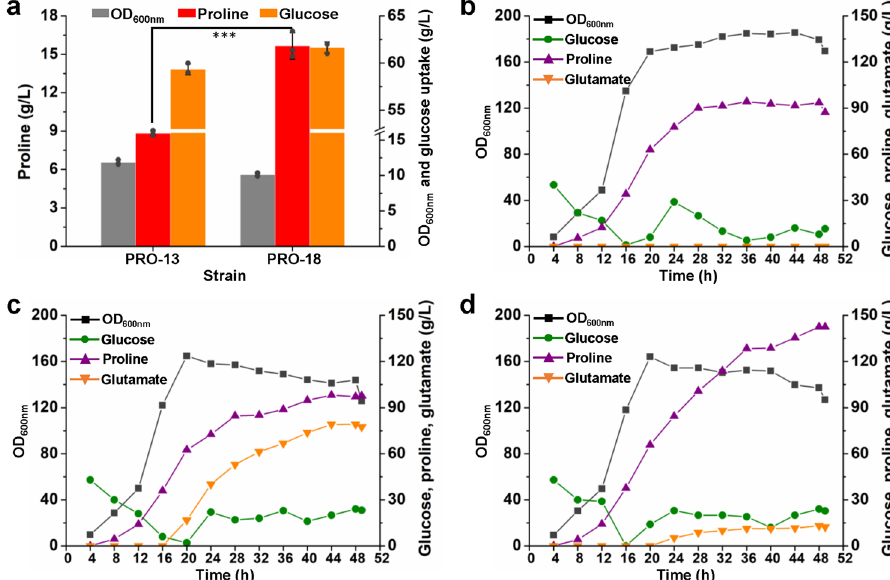
Fig. 7 L -Proline production using strains with transport engineering. a Effects of cgl2622 overexpression on L -proline production in 24-deep-well plates. Strain PRO-18 was constructed by adding a second copy of cgl2622 controlled by the derepressed P trc promoter in the chromosome of strain PRO-13. Data are presented as mean values + / − SD ( n = 3 independent experiments). *** P = 0.0004, Student ’ s two-tailed t -test. b Fed-batch fermentation of strain PRO-18 in a 5 L bioreactor with 1 mg/mL biotin for a biotin-rich condition. c Fed-batch fermentation of strain PRO-18 in a 5 L bioreactor with 45 μ g/mL biotin for a biotin-limited condition. d Fed-batch fermentation of strain PRO-19 (strain PRO-18 with cgl1270 ( mscCG ) deleted) in a 5 L bioreactor. Biotin was used at 45 μ g/mL for a biotin-limited condition. Source data underlying Fig. 7 are provided as a Source Data fi